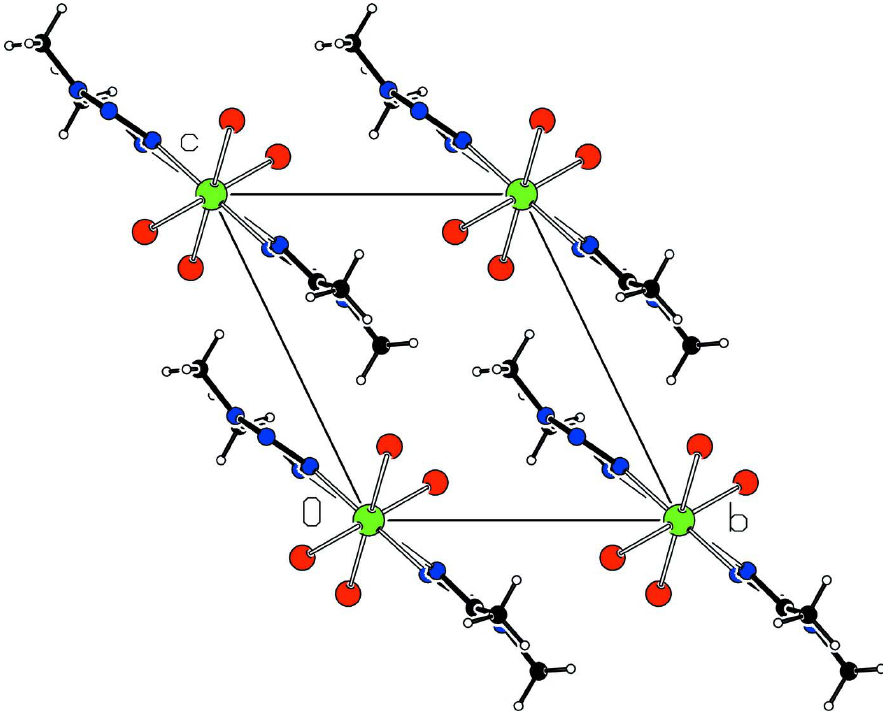
Figure 2 The crystal structure of (I), viewed along the a